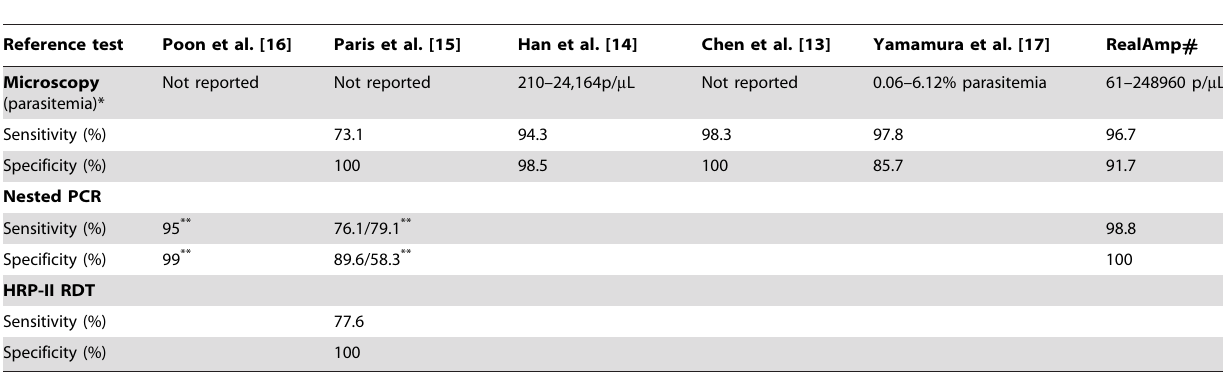
Table 5. Summary of sensitivity and specificity of malaria LAMP assays reported in the literature.